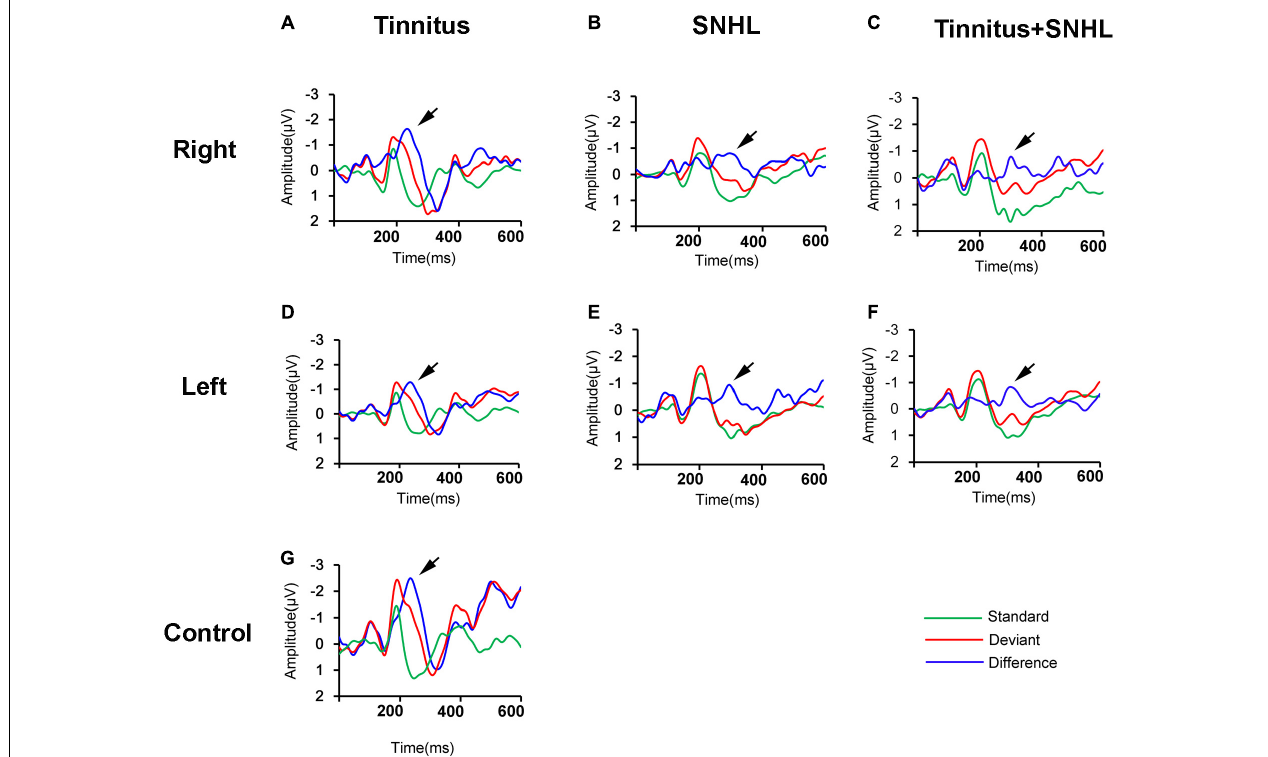
FIGURE 1 | (A–F) The grand averaged waveforms of patients with tinnitus, SNHL and tinnitus/SNHL of the right and left ears, respectively. (G) The grand averaged waveforms of the control subjects. All waveforms were recorded from the Fz electrode. Standard: response to standard stimuli; Deviant: response to deviant stimuli; Difference: difference waveforms. The black arrow indicates the